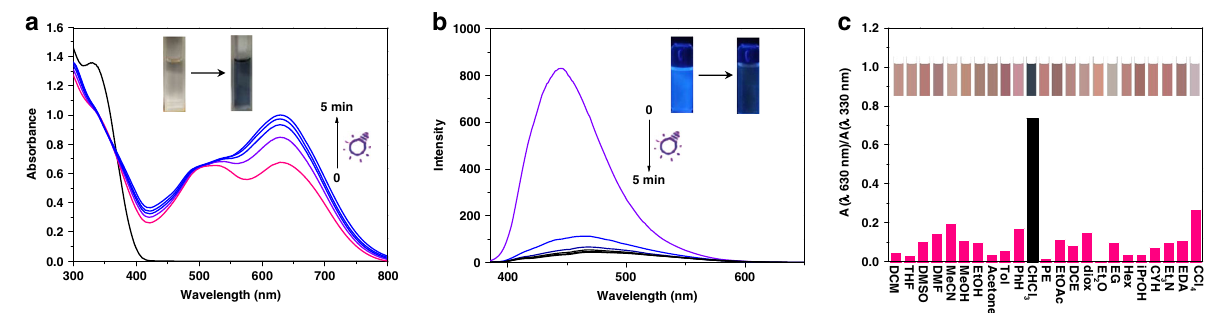
Fig. 2 Photochemical properties. a UV – vis absorption spectral and b fl uorescence spectral changes of compound 1 (5.0 × 10 − 5 M) in oxygen-saturated CHCl 3 solution upon irradiation with 365 nm light at room temperature. c The absorption ratio (A 630 nm /A 330 nm ) of compound 1 in a series of solvents and the corresponding color